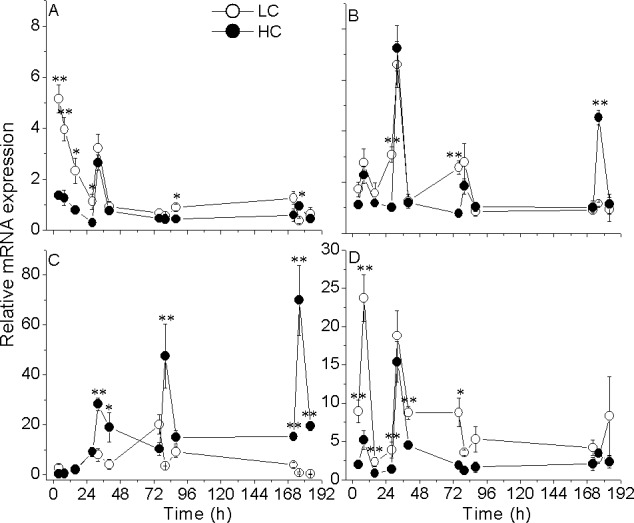
The relative abundances of transcripts for non-photosynthetic relevant genes.The time series of the relative abundances of transcripts for mitochondrial ATP synthase (mATP; A), peroxisomal membrane protein (PMP; B), nitrite reductase (NiR; C) and NADH dehydrogenase subunit 2 (Ndh2; D) determined by quantitative real-time PCR (qPCR) of P. tricornutum cells grown at ambient (390 μatm; LC) and elevated CO2 (1000 μatm; HC) levels. Data are presented as means ± SD, n = 3 (triplicate cultures). Two asterisks indicate significant difference between HC and LC grown cells at p < 0.01, and one asterisk represents a difference at p < 0.05